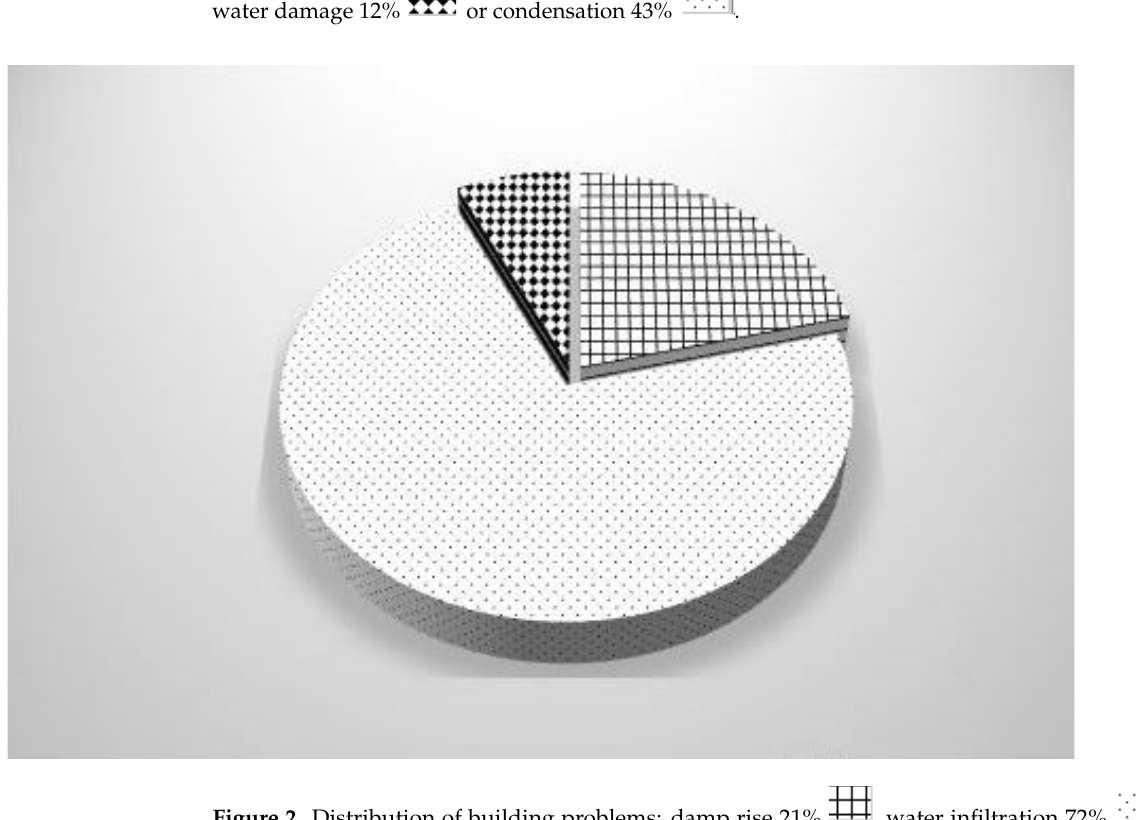
, water infiltration 72% or